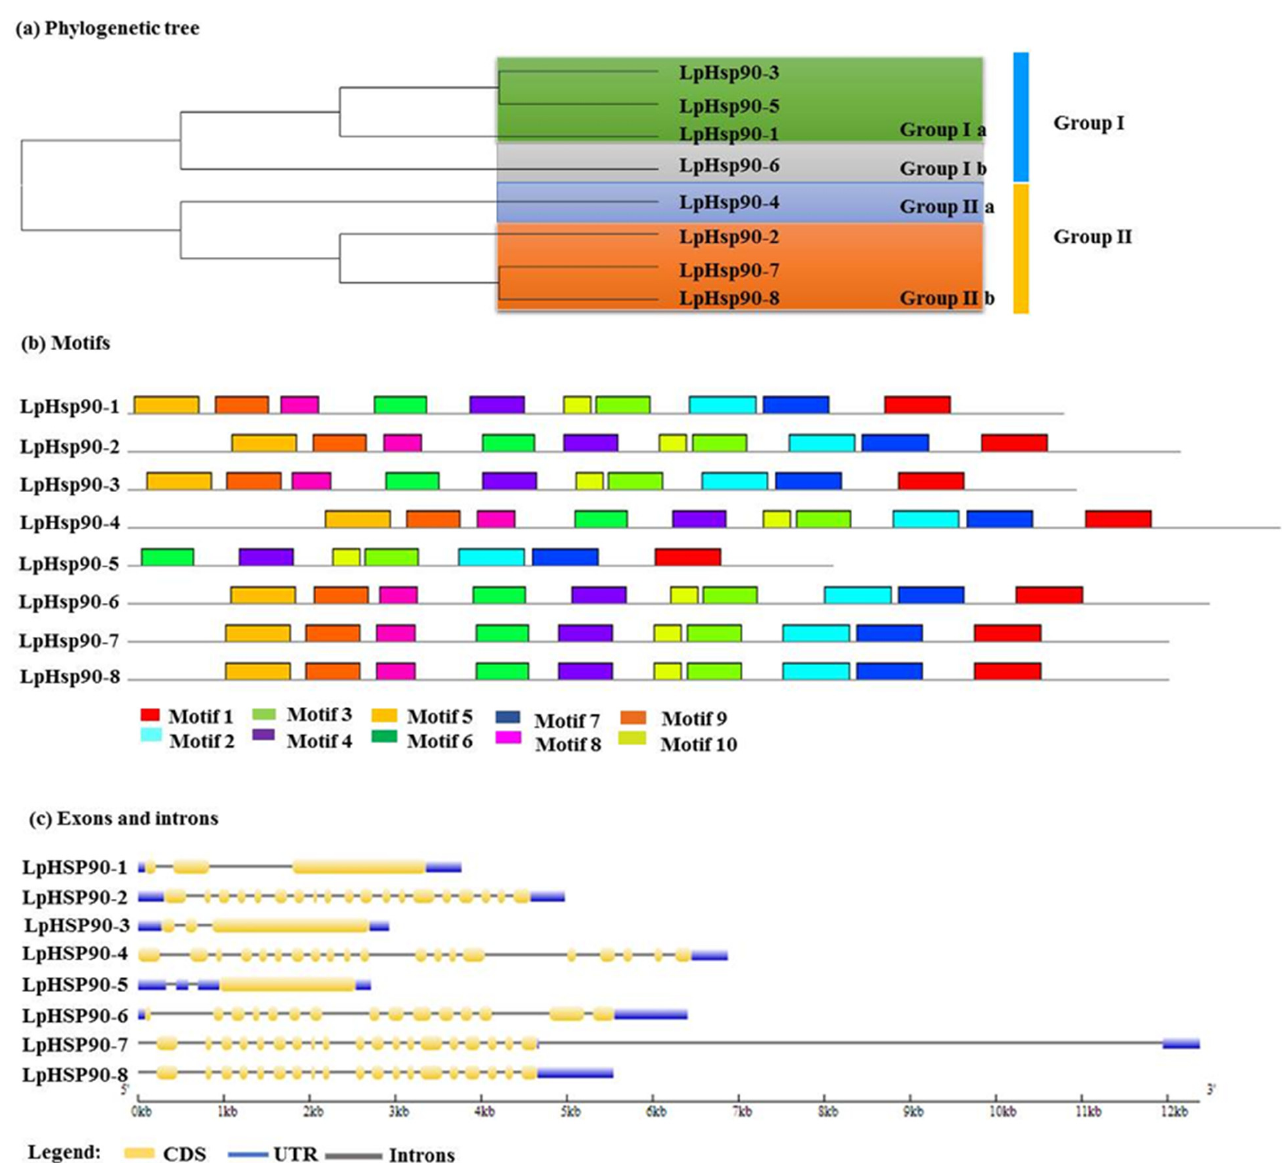
Figure 2. Phylogenetic relationship, gene structure and motif composition of Hsp90 genes in perennial ryegrass. ( a ) A multiple sequence alignment of the full length of LpHsp90 protein sequences was executed using Clustal W, and a maximum-likelihood phylogenetic tree with 1000 bootstraps was constructed using MEGA 6.0 software. The four subgroups were marked with different colors. ( b ) Schematic representation of the conserved motifs obtained using MEME online tool in LpHsp90 proteins. Different motifs are represented by colored boxes of corresponding colors. The grey lines represent the non-conserved. ( c ) The exon/intron structure of the LpHsp90 protein sequences was obtained employing the online tool